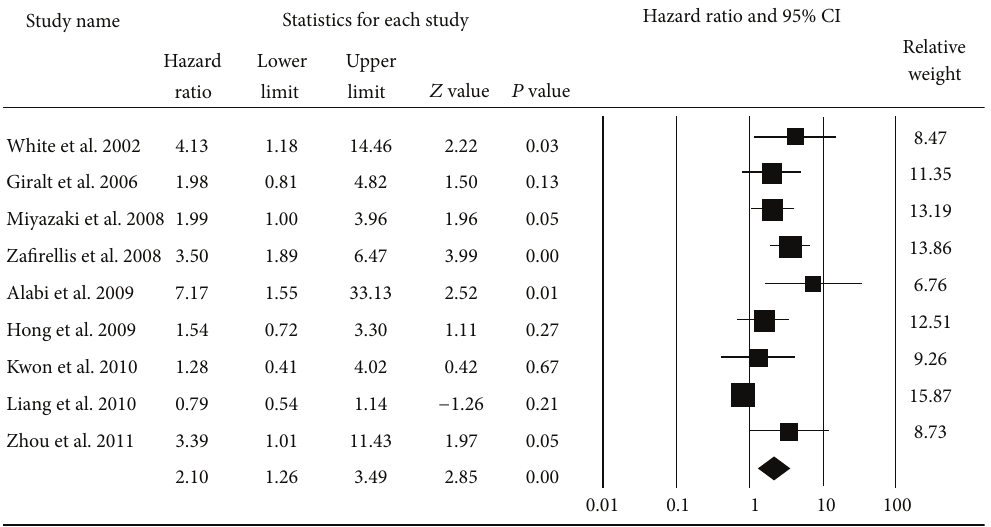
Figure 3: Forest plot for the association between VEGF expression and disease-free survival of